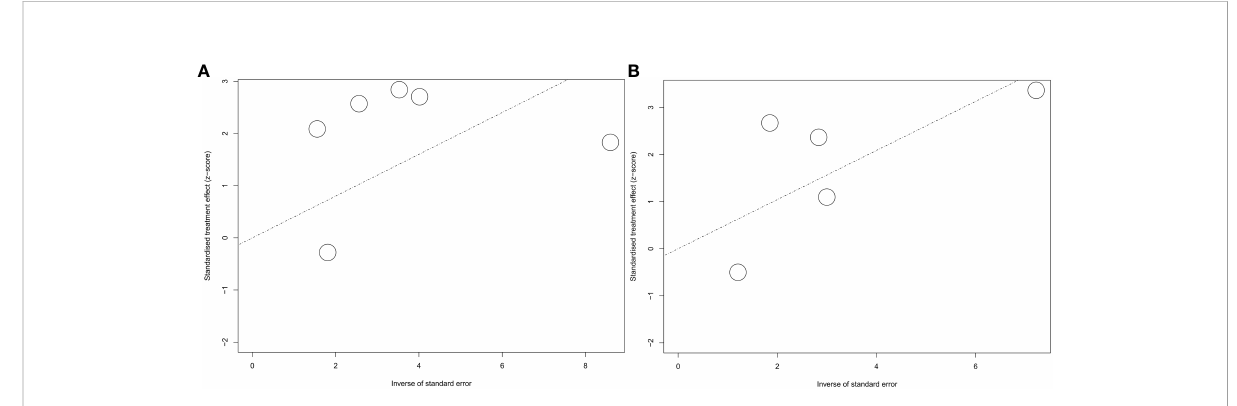
FIGURE 7 Funnel plot for hazard ratios for PFS and OS. A , funnel plot for PFS; B , funnel plot for